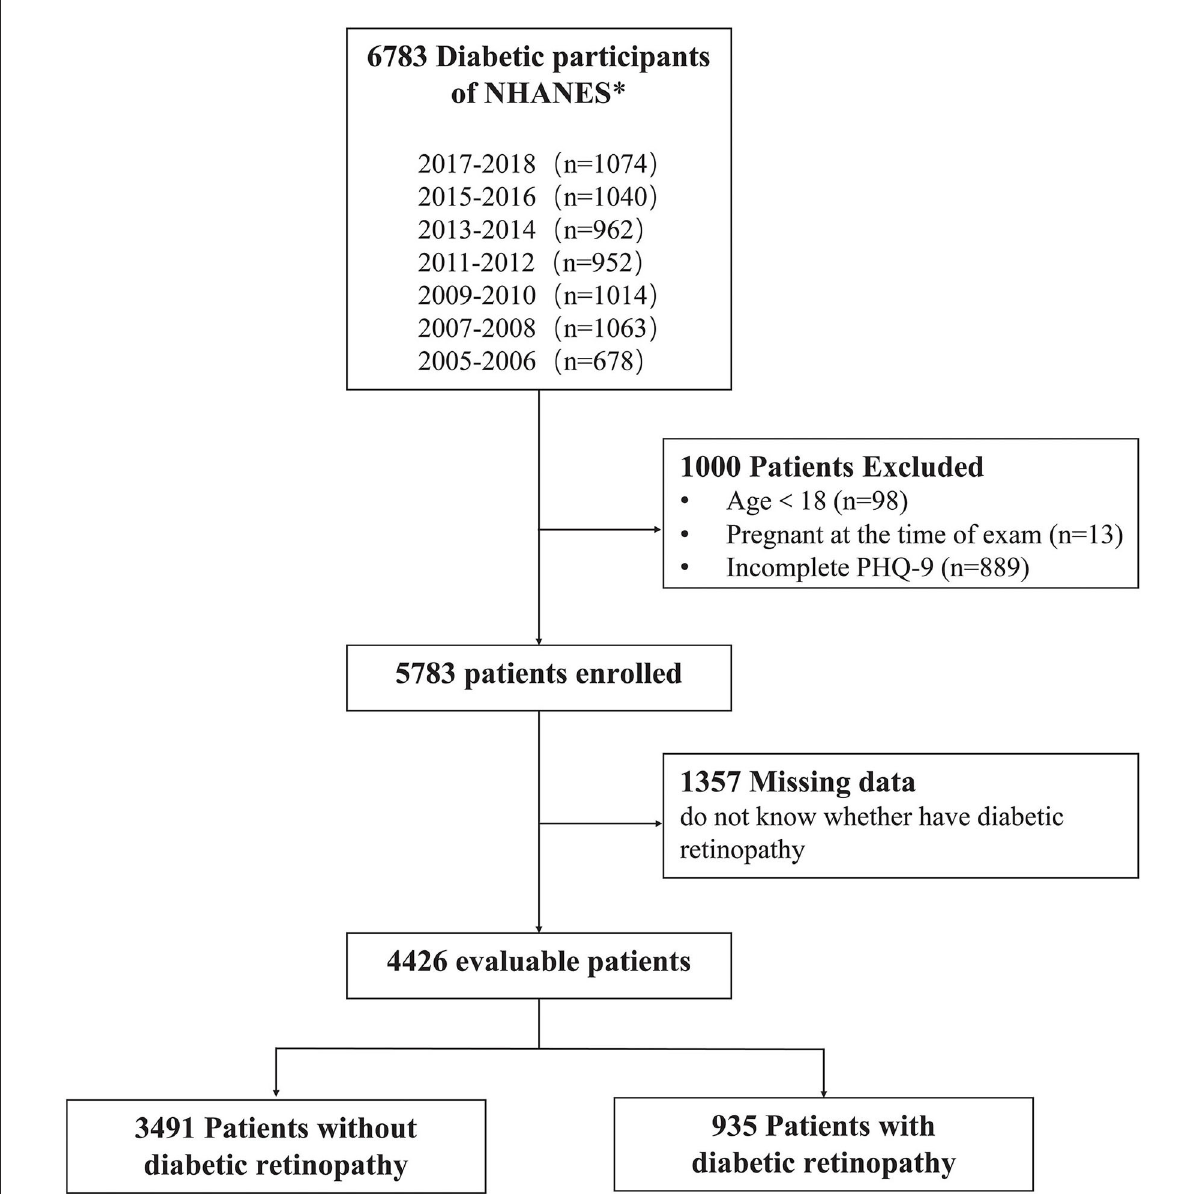
FIGURE1 Flow diagram of the study population’s inclusion and exclusion criteria. 2005–2018 National Health and Nutrition Examination Survey (NHANES).